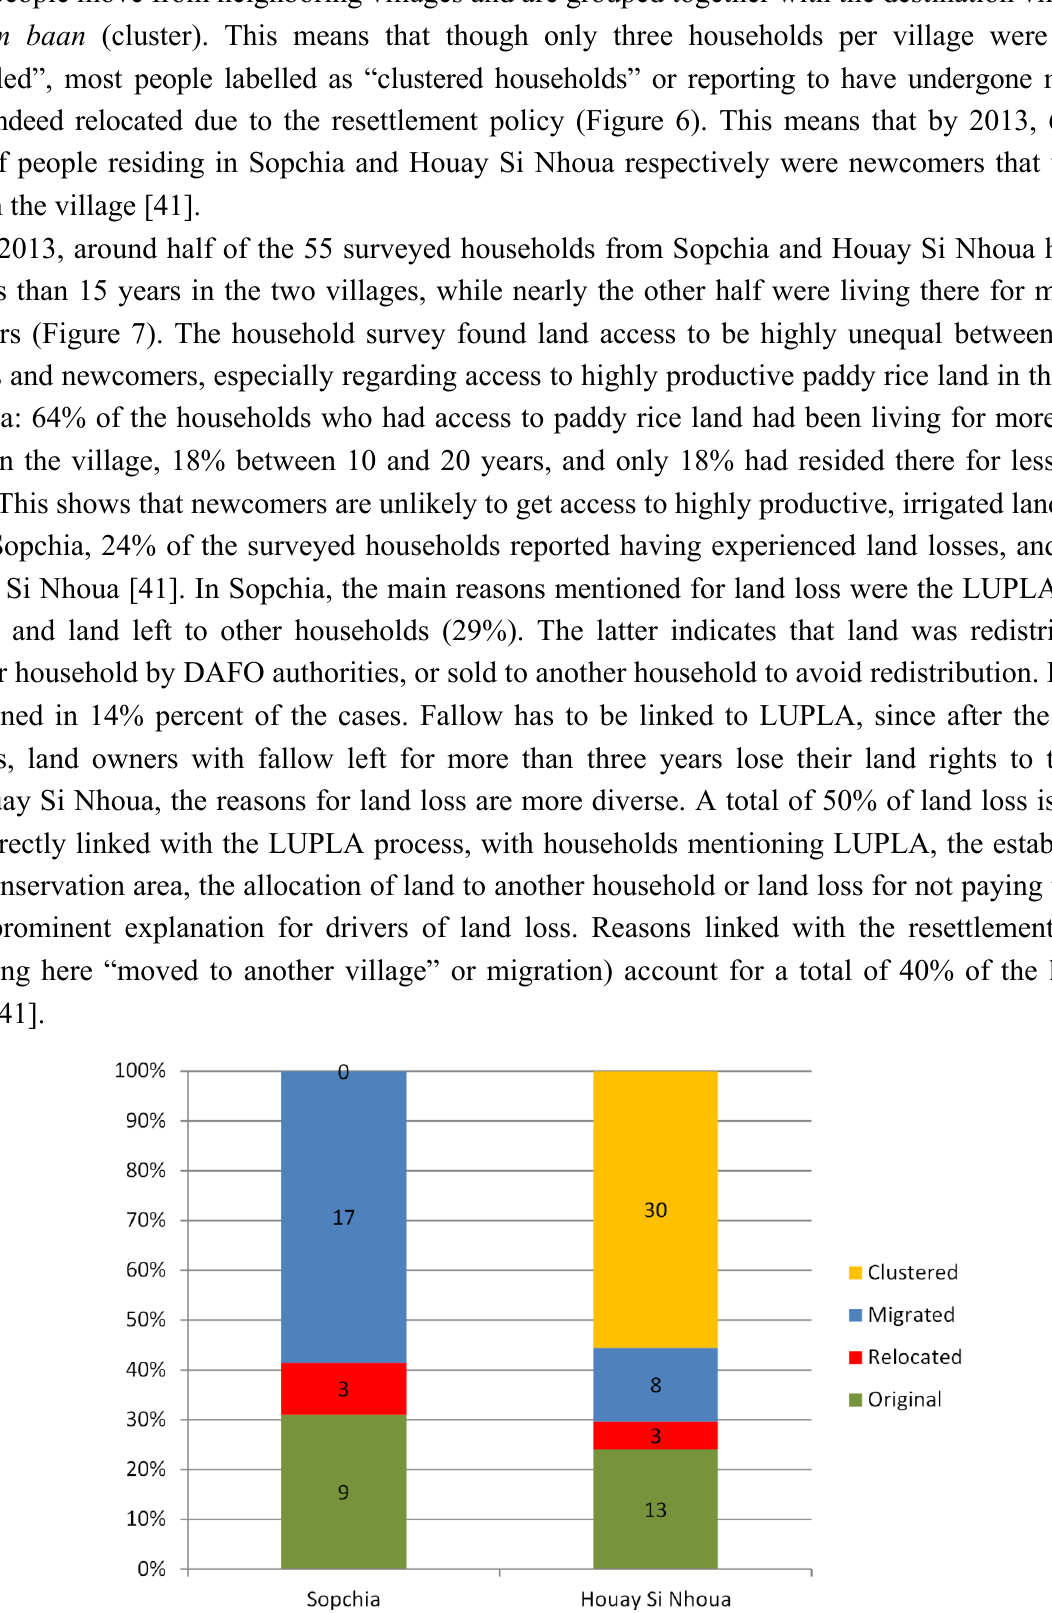
Figure 6. Origin of households in Sopchia and Houay Si Nhoua (Source: Stich